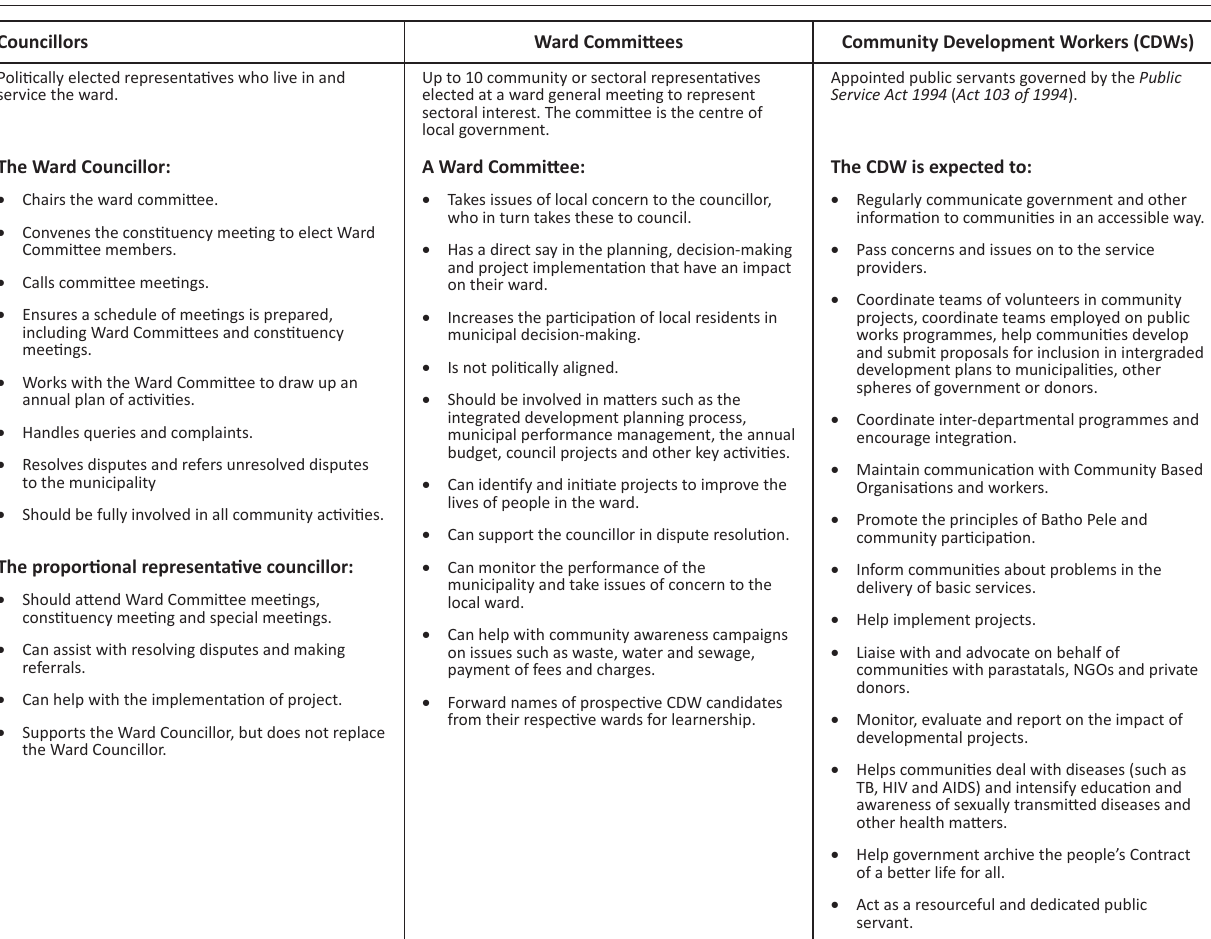
Councillors Ward